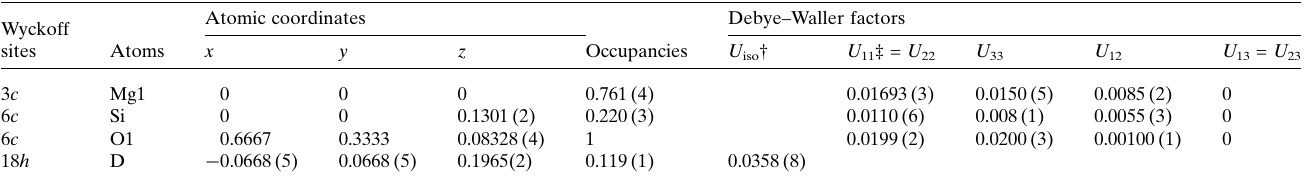
Table 1 Refined structural parameters at d min = 0.50 A˚ . The lattice parameters are a = 2.9647 (4) and c = 13.8892 (3) A˚ , determined by single-crystal neutron diffraction at 100 K.